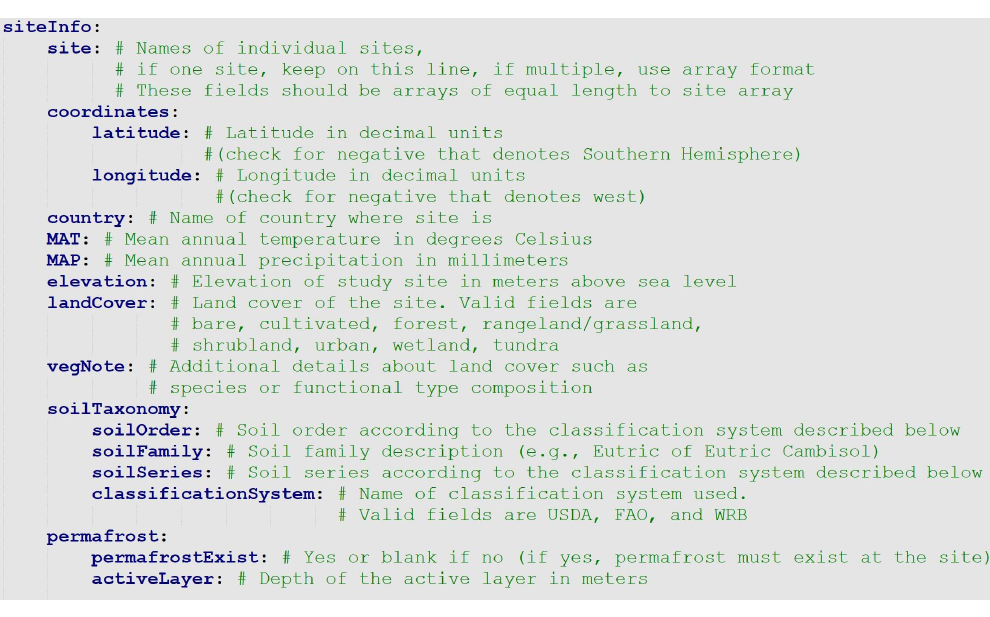
Figure 3. Site information for each database